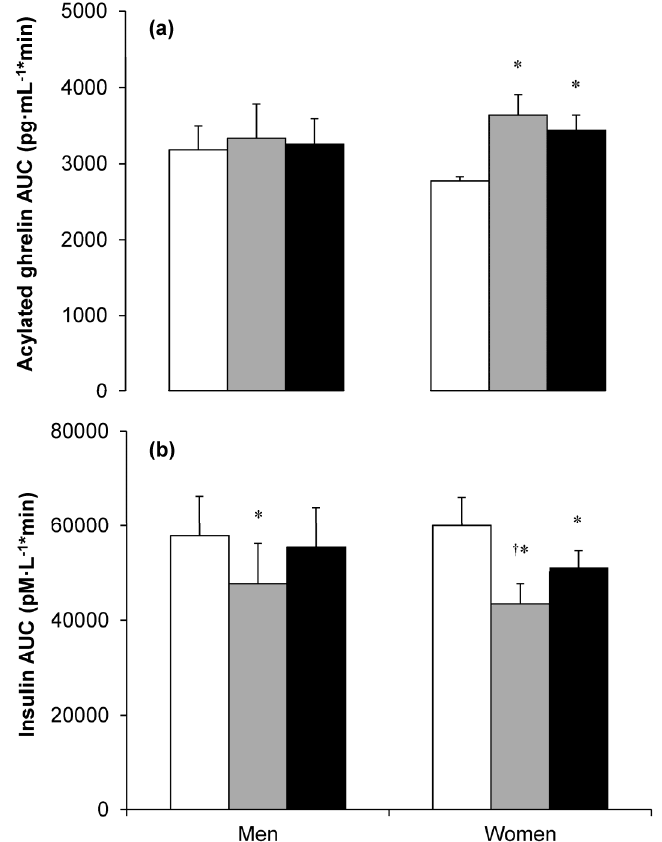
Figure 3. Total area under the curve (AUC) for plasma acylated ghrelin ( a ) and insulin ( b ) concentrations in the control ( □ ), exercise with energy deficit ( ■ ) and exercise with energy balance ( ■ ) conditions in nine men and nine women. Exercise involved four consecutive days of treadmill exercise at 50%–65% peak oxygen uptake until 30% of total daily energy expenditure was expended. * Significant difference between exercise intervention and control; † Significant difference between exercise with energy deficit and exercise with energy balance. Values are mean (error bars not stated in original article). Data reproduced from reference [13]. © The American Physiological Society. Reproduced with permission.